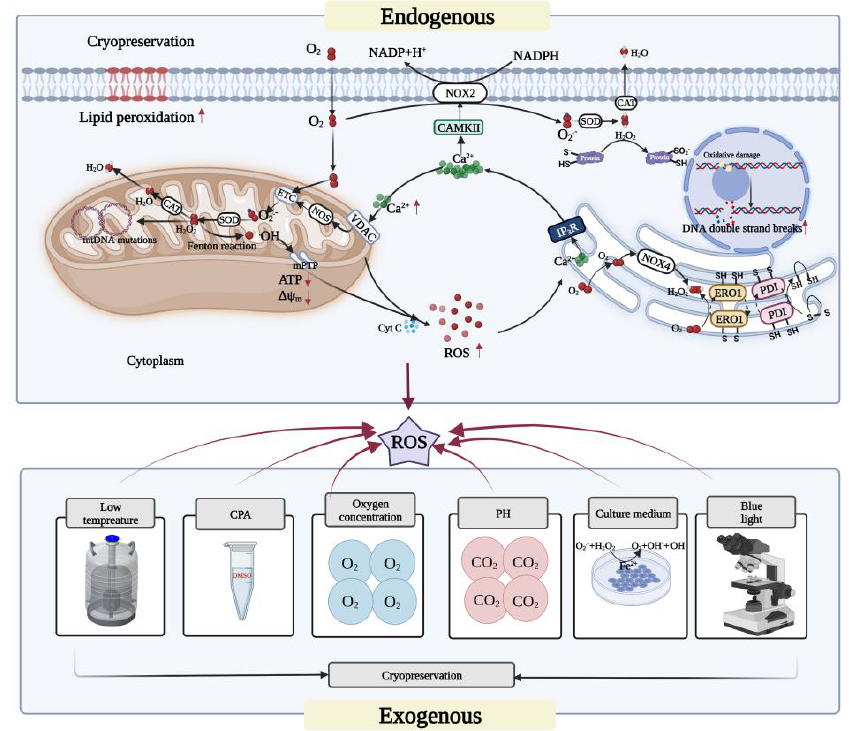
Figure 1. The sources of ROS in oocyte cryopreservation and its effects on oocytes. The exogenous ROS during oocyte cryopreservation mainly come from the environment and the reagents used in the experimental procedures. Mitochondria are the main sites for the generation of endogenous ROS, and some oxidases can also generate ROS. The ROS generated in the respiratory chain are released in large quantities through mPTP, which can enhance protein misfolding and trigger ER stress. Meanwhile, a large amount of ROS can also be generated in the ER. In addition, the ER re- leases large amounts of Ca 2+ into the cytoplasm, which generates ROS, in part through NOX. Others are absorbed by the anion channel protein VDAC in mitochondria, causing Ca 2+ overload, which further increases the levels of ROS produced by mitochondria, decreases ATP and mitochondrial membrane potential, and causes oxidative damage to cellular lipids, proteins, and DNA. ↑ and ↓ , respectively, indicate a significant increase or decrease. Created with BioRender.com (accessed on 19 October 2022). 3. Sources of ROS in Oocyte Cryopreservation ROS in oocyte cryopreservation can originate from both intracellular production and external environmental factors (see Figure 1). During oxidative metabolism, the intracel- lular source of ROS is mainly from the by-products produced by mitochondrial complexes I and III in the respiratory chain. ROS are also produced by oxidative enzymatic reactions of NADPH oxidase (NOX) [17] and nitric oxide synthase (NOS) located on the cell mem- brane and in the cytoplasm. Furthermore, during endoplasmic reticulum stress (ERS), the endoplasmic reticulum can also produce ROS through oxidative enzymes such as NADPH oxidase 4 (NOX4). Extracellular sources of ROS include cryoprotective agents such as dimethyl sulfox- ide (DMSO), which promotes the release of large amounts of calcium ions (Ca 2+ ) from the endoplasmic reticulum into the cytoplasm, and then the uptake of more Ca 2+ by the mito- chondria, inducing more ROS production [23]. In turn, the extreme stimulus of low tem- peratures can exacerbate the production of ROS in the presence of DMSO [23]. Given that oocyte cryopreservation is performed in vitro, certain light in the experimental environ- ment, such as blue light (400 – 500 nm), can cause oxidative damage to cells by generating